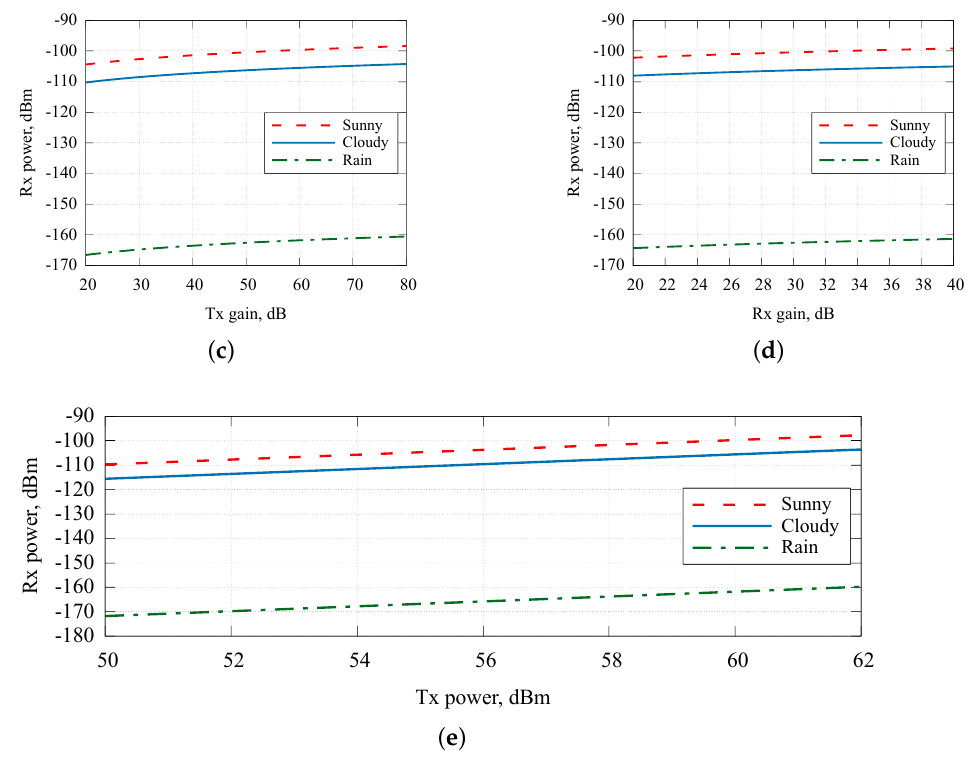
Figure 6. The received power in the equator Earth zone. ( a ) Rx power as a function of frequency; ( b ) Rx power as a function of altitude; ( c ) Rx power as a function of Tx gain; ( d ) Rx power as a function of Rx gain; ( e ) Rx power as a function of Tx power.